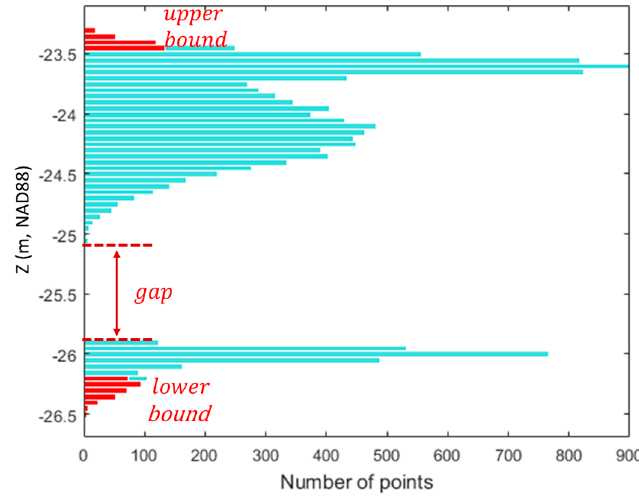
Figure 2. Histogram representing the number of points of a grid cell. The gap between the seafloor and non-seafloor and the bins within the lower and upper bounds are highlighted in red.